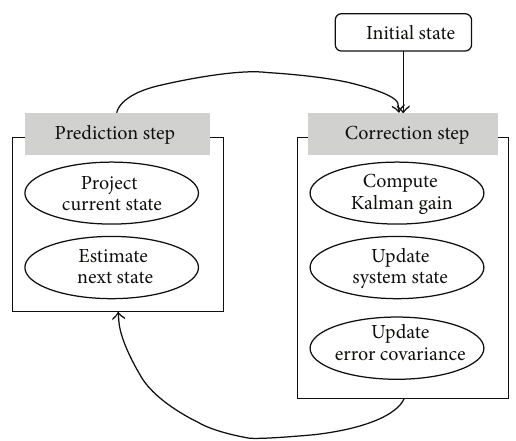
Figure 1: Recursive cycle of the Kalman